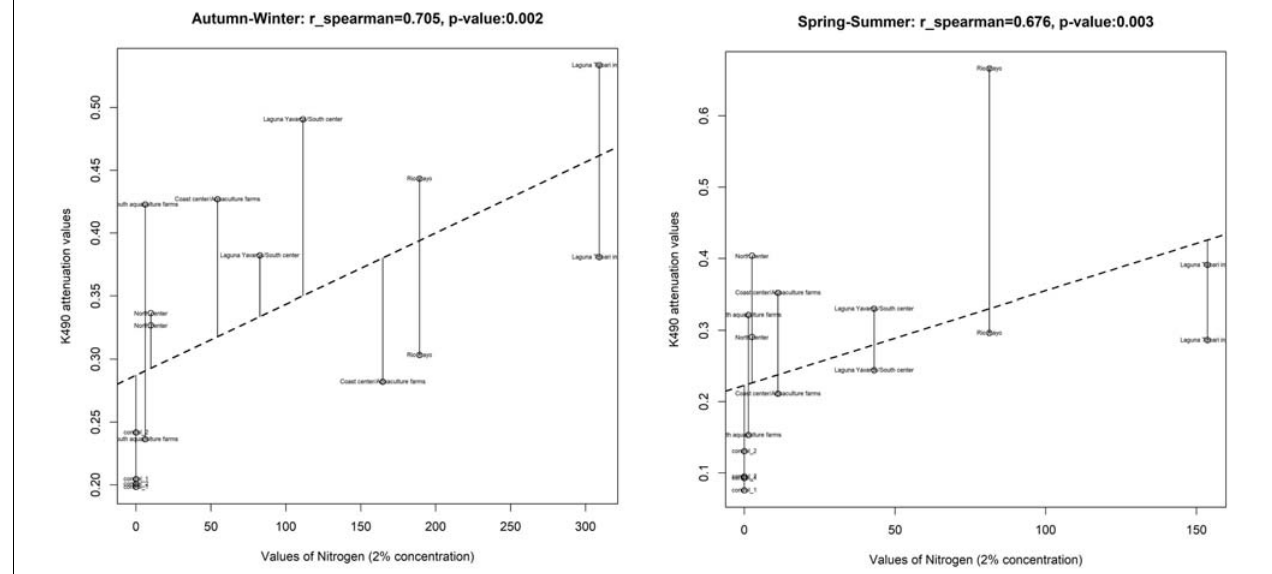
FIGURE 6 | The correlation analysis between the Kd(490) and the runoff nitrogen values for both agricultural